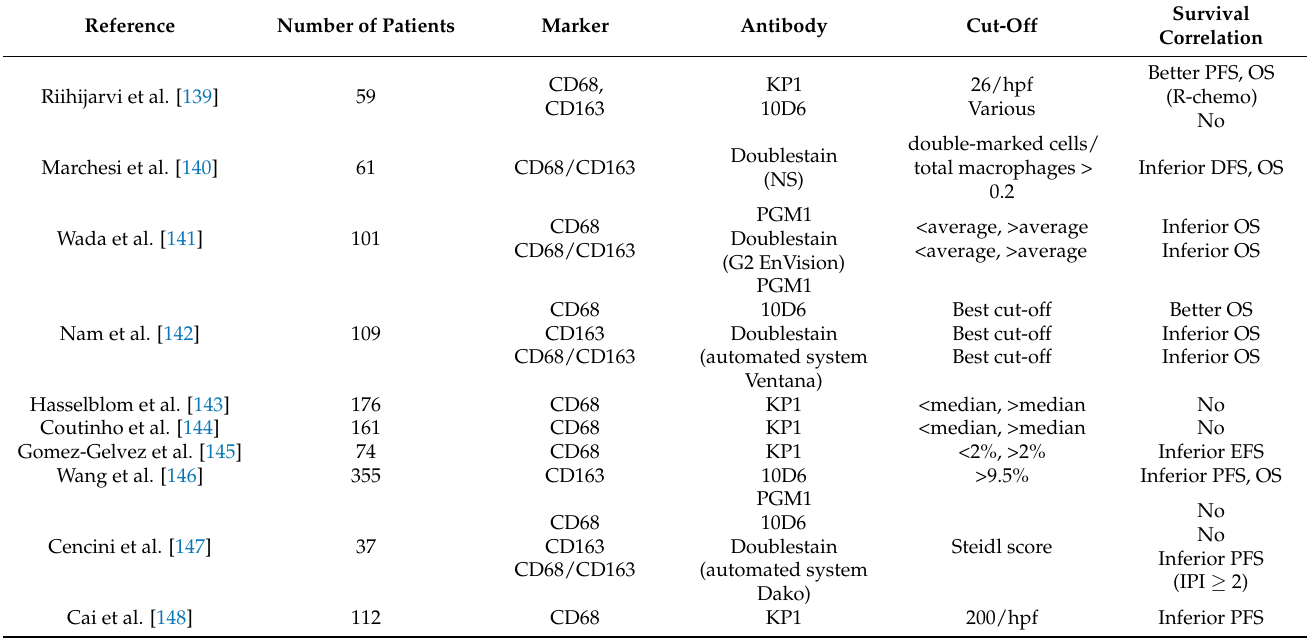
Table 2. Clinical studies about prognostic role of tumor-associated macrophages (TAM) in diffuse large B-cell lymphoma.